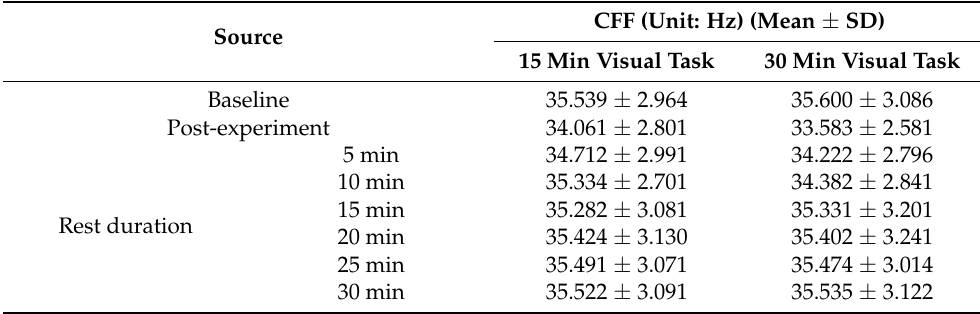
Table 2. Means and standard deviation results for CFF values for each visual task at baseline, post-experiment, and in the rest session.